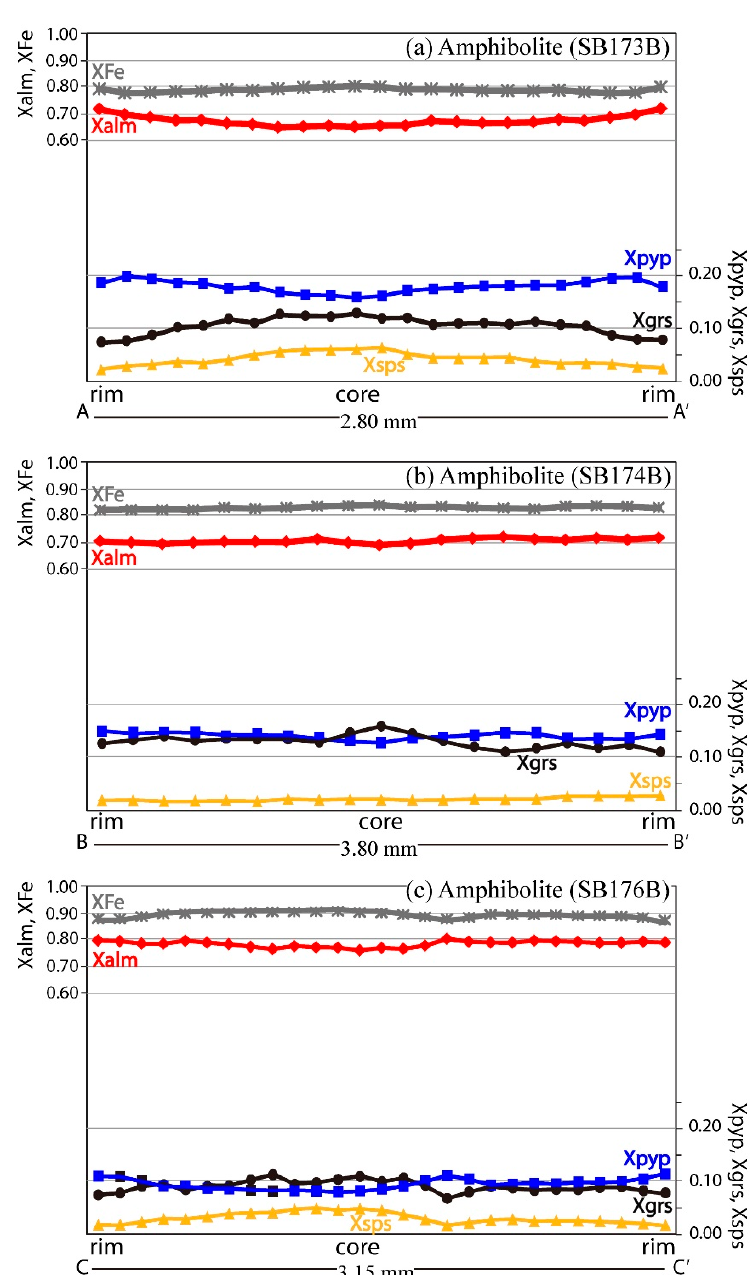
Figure 8. Representative compositional zoning profiles of garnet in amphibolites from the Dessent Unit. ( a ) Garnet porphyroblast of the amphibolite (SB173B), ( b ) a part of the elongated garnet band of the amphibolite (SB174B) and ( c ) garnet porphyroblast of the amphibolite (SB176B). Each profile and profile composition are presented in Figure 4 and Table S3, respectively.